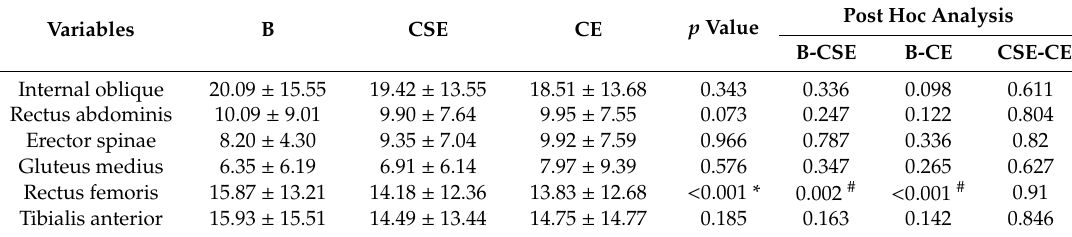
Table 5. Comparison of muscle activation in the eye-closed